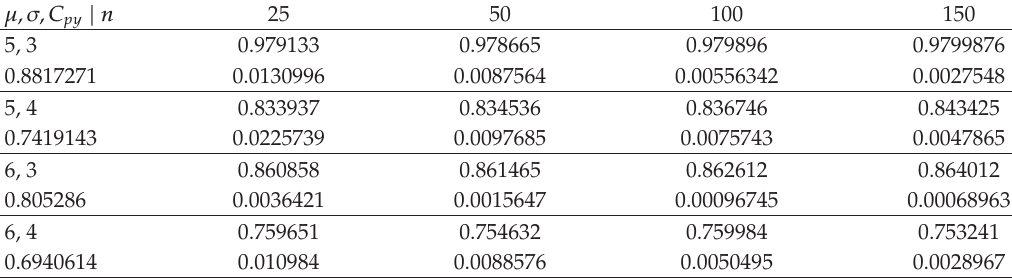
Table 2: Bayes Estimates of C distribution.